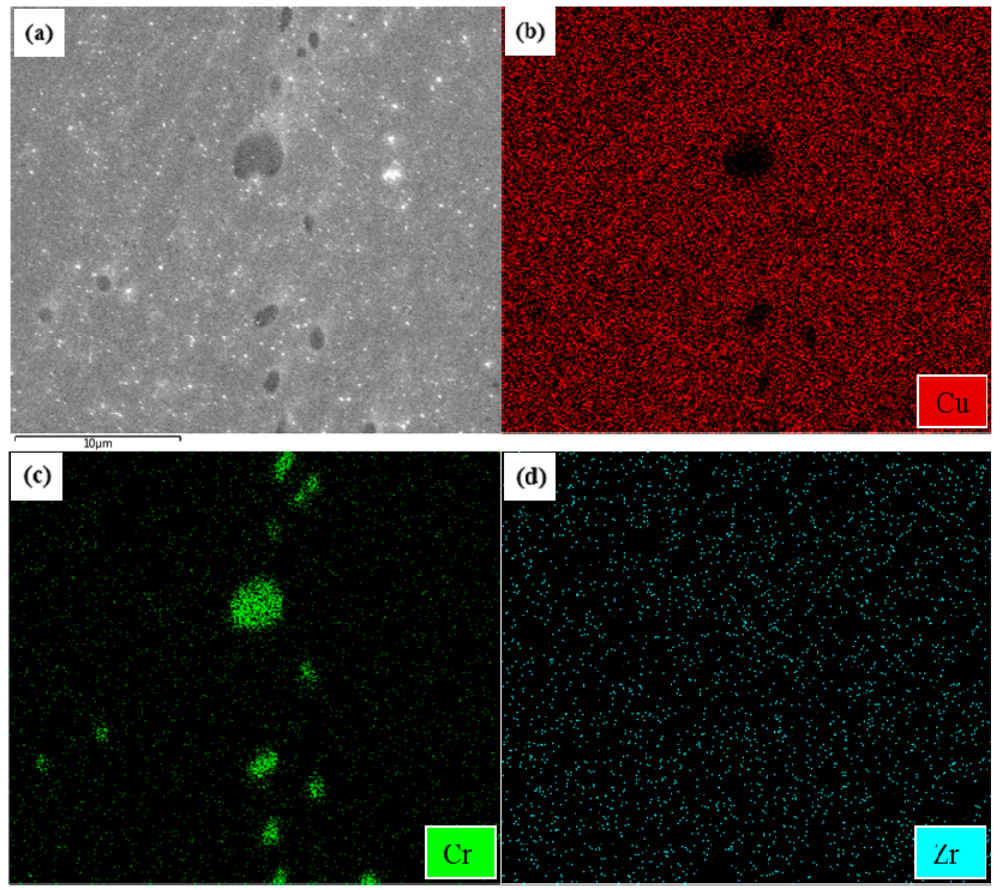
Figure 5. Scanning electron microscopy (SEM-EDX) mapping analysis of CuCrZr alloy. ( a ) Micrograph of the surface revealing the presence of intermetallic particles, ( b ) Copper, ( c ) Chromium, ( d ) Zirconium.